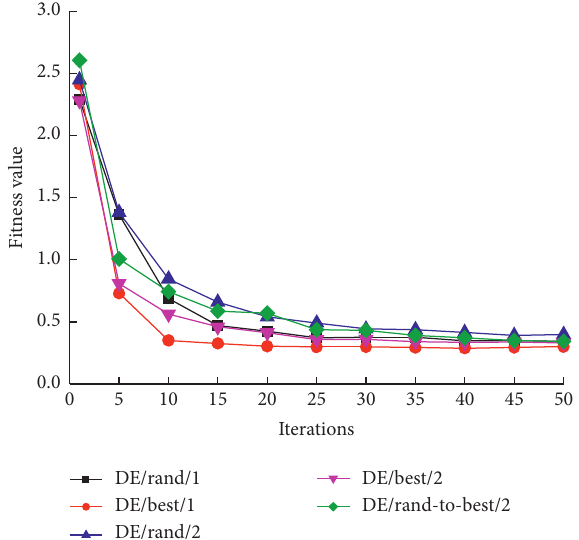
Figure 17: Different differential